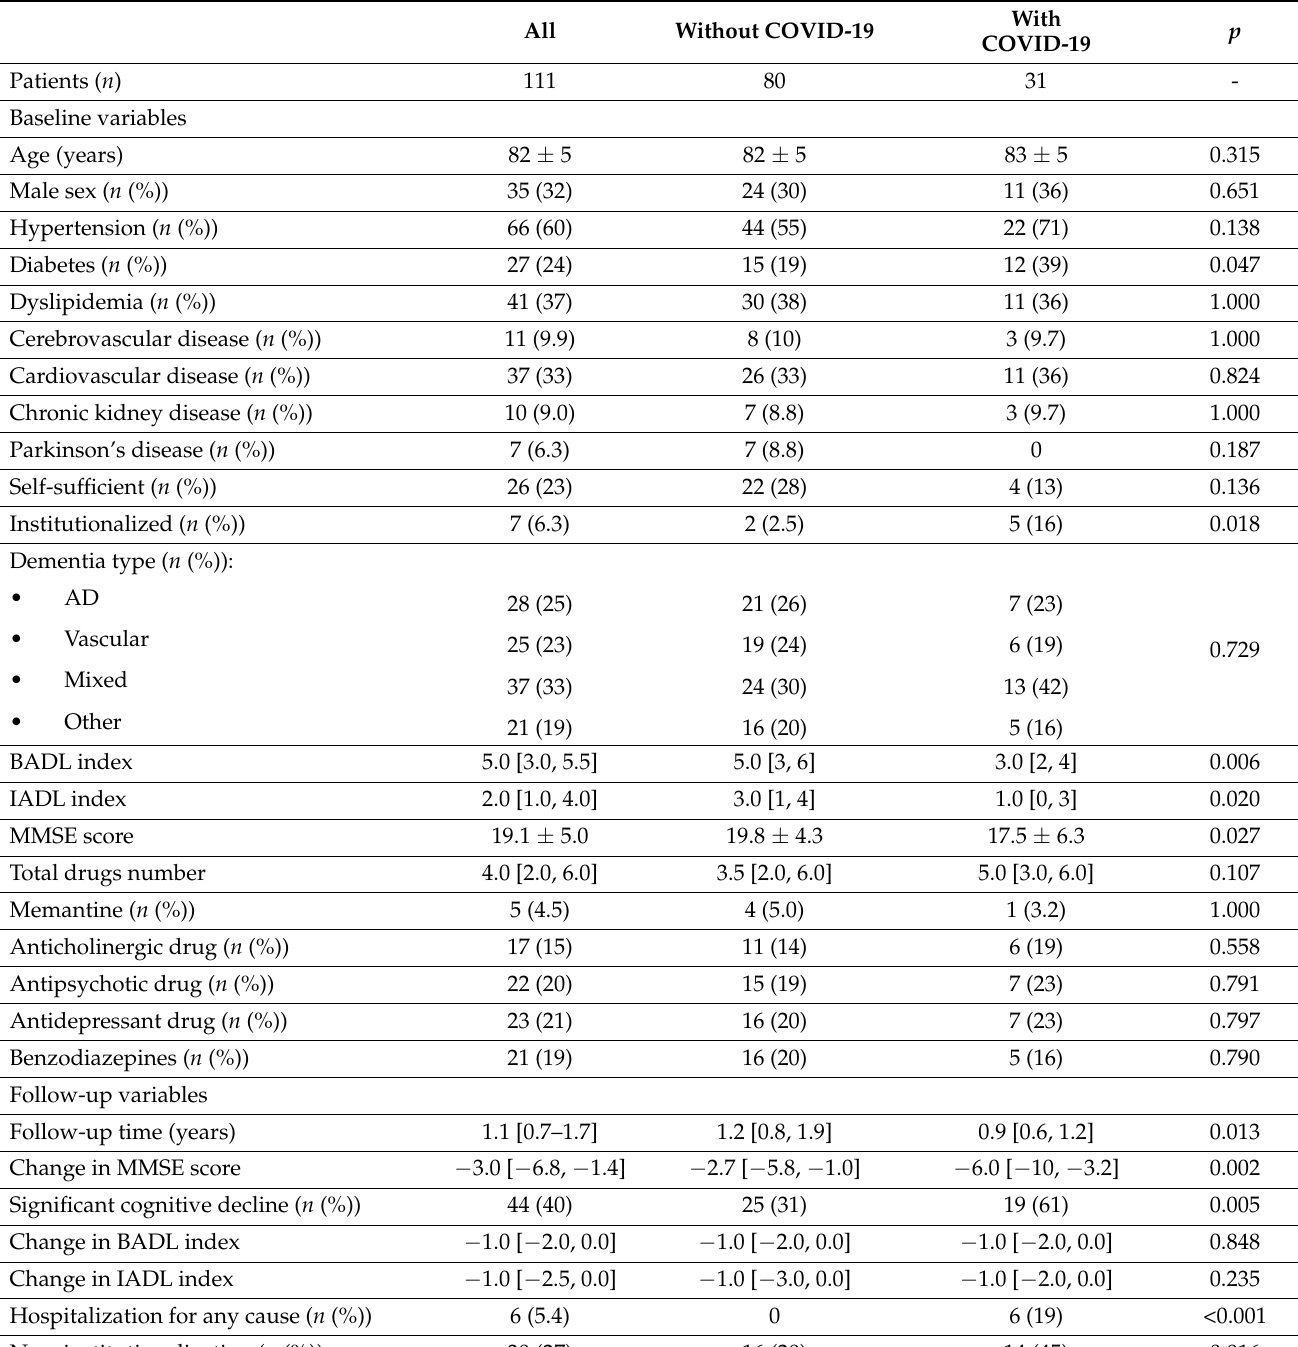
Table 1. General clinical and laboratory characteristics of all patients and according to COVID-19 occurrence. All Without COVID-19